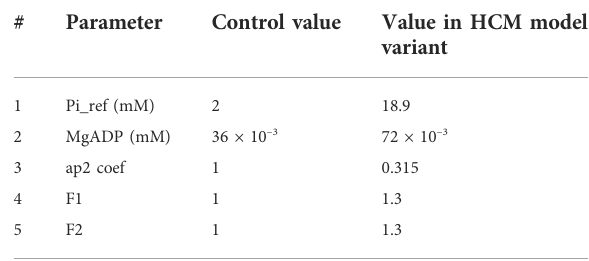
TABLE2TheparameterusedintheHCMmodelvariant.Pi_refdenotes thereferencevalueforinorganicphosphate(Pi)inthesimulations. Ap2 is a variable in fl uencing detachment of crossbridges. F1 and F2 are coef fi cients affecting pre-rotational states in XB cycling as also used in (Margara et al., 2021).